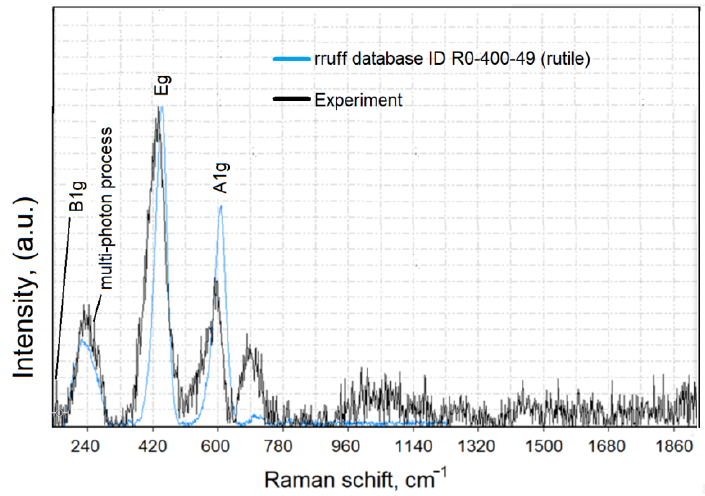
Figure 4. Raman spectra of rutile TiO 2 .